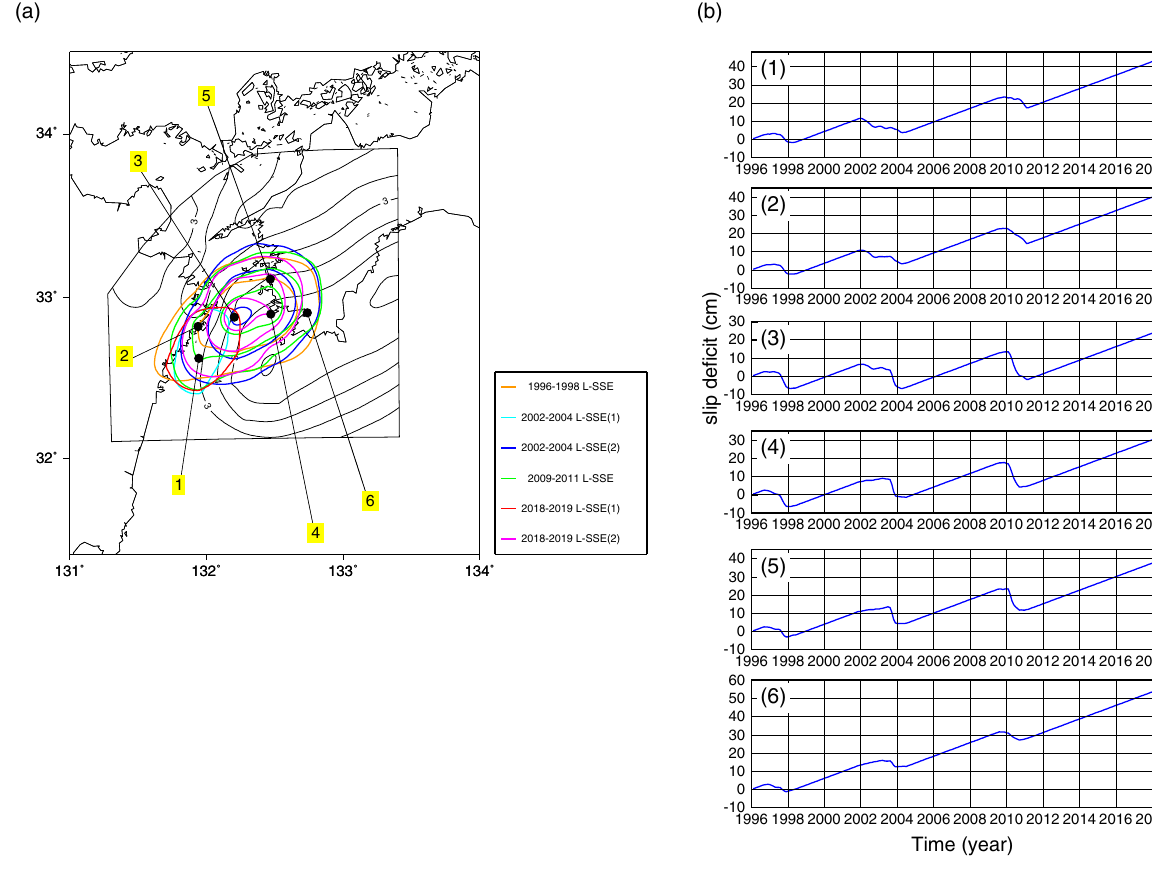
Figure 7. ( a ) Slip distributions for the three L-SSEs by Yoshioka et al. 7 and the L-SSE obtained in this study and slip deficit rate distribution. The colour contour lines represent slip distributions for the 1996–1998 L-SSE (in orange) between 1996.7 and 1998.5, the 1st subevent of the 2002–2004 L-SSE (in light blue) between 2001.9 and 2004.5, the 2nd subevent of the 2002–2004 L-SSE (in blue) between 2001.9 and 2004.5, the 2009–2011 L-SSE (in green) between 2009.5 and 2011.2, the 1st subevent of the 2018–2019 L-SSE (in red) between 2018.3 and 2018.7, and the 2nd subevent of the 2018–2019 L-SSE (in pink) between 2018.8 and 2019.4. The contour interval is 5 cm. The black contour lines denote the slip deficit rate distribution of Model 1 of Yoshioka and Matsuoka 14 . Their contour interval is 1 cm/yr. The solid black numbered circles are locations to show the slip deficit budget in ( b ). ( b ) The cumulative amounts of slip deficit since 1996.5, which were calculated from the amount of slip deficit rate of Model 1 of Yoshioka and Matsuoka 14 and the slip amounts associated with the 1996–1998, 2002–2004, 2009–2011, and 2018–2019 L-SSEs. (1)–(6) represent the slip deficit budget at the locations shown in ( a ). Positive and negative directions denote the accumulation and release of slip deficits, respectively. The map was created by using the Generic Mapping Tools (GMT) 15 (version: GMT 4.5.7, URL link: https:// www. gener ic- mappi ng- tools. org/ downl